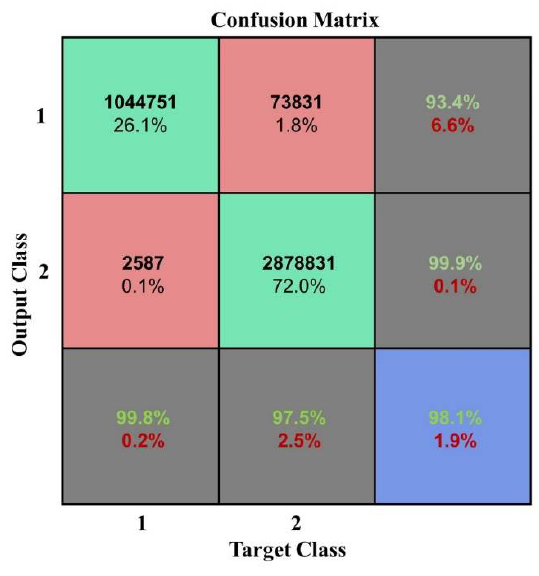
Figure 15. Confusion matrix at a learning rate of 0.01.